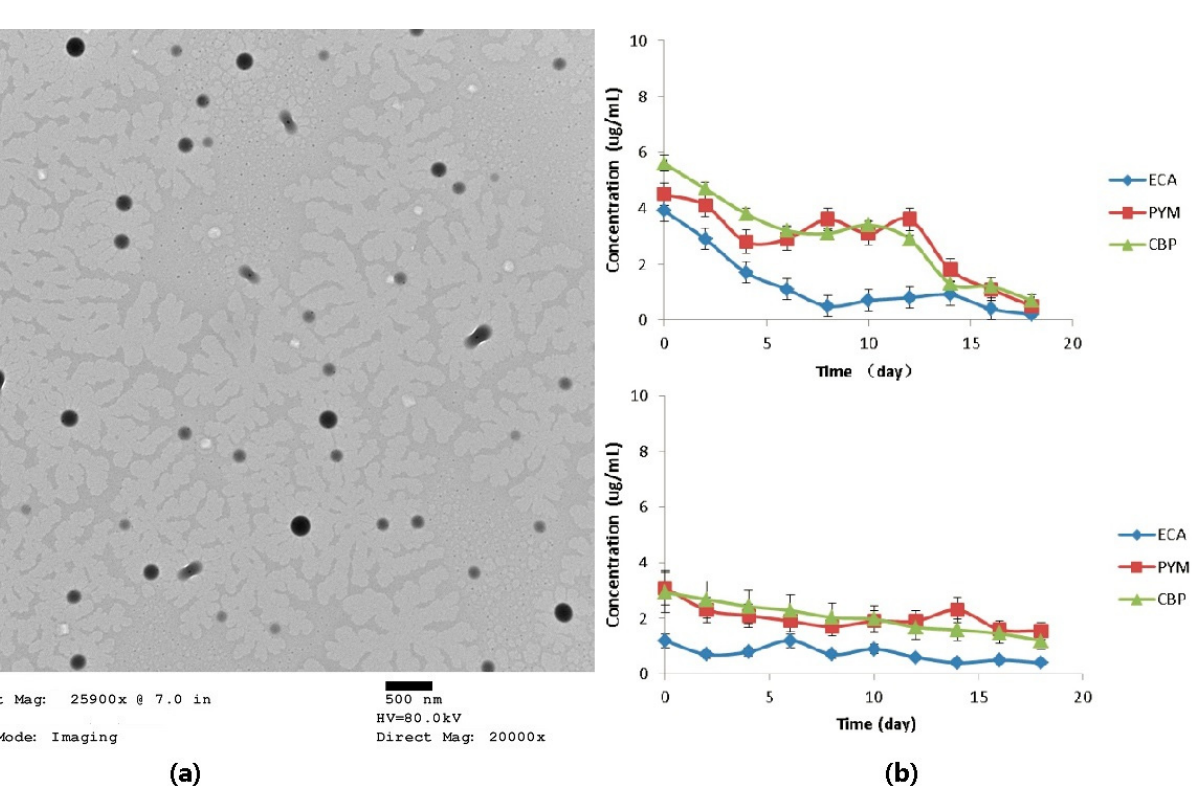
Figure 2. ( a ) Transmission electron microscope (TEM) pictures of MPEG–PLA–SS–ECA nanoparticles; ( b ) Cumulative release rates of nanoparticles in vitro